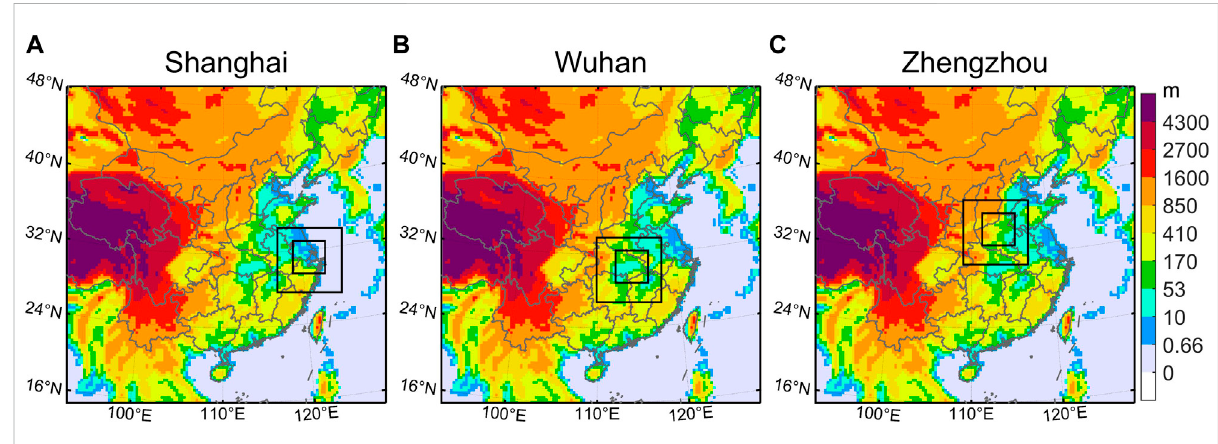
FIGURE 1 The WRF-Chem modeling domainfor the case of (A) Shanghai, (B) Wuhan, and (C) Zhengzhou. The outmost region represents domain 1, while the black rectangle in the middle represents domain 2, and the innermost black rectangle represents domain